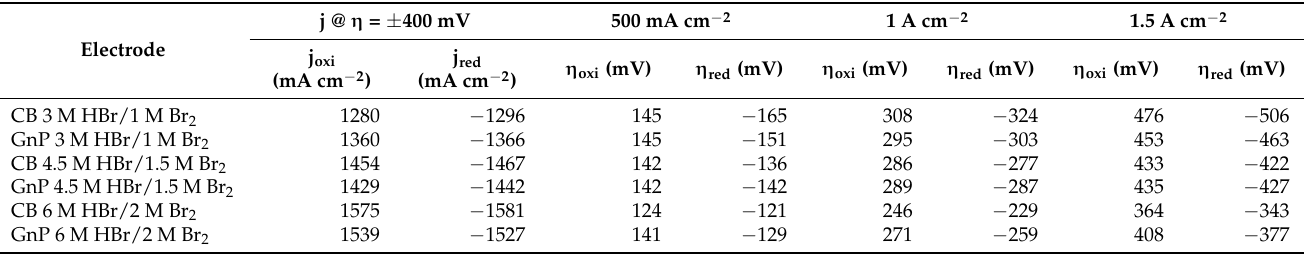
Table 4. Results of polarisation and oxidation/reduction cycling tests on HCB1071 carbon cloth. Data taken from Figure